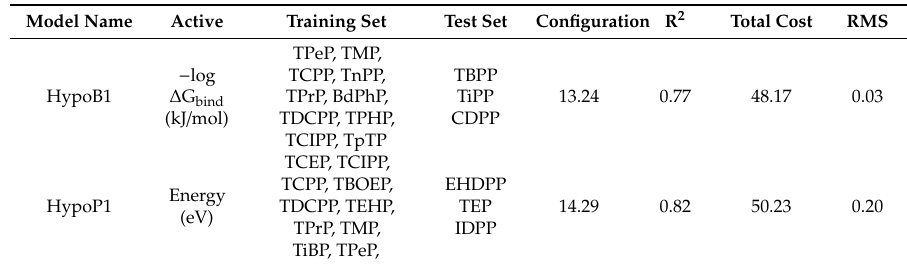
Table 4. Optimal pharmacophore model parameters for biodegradation and photodegradation of OPFR